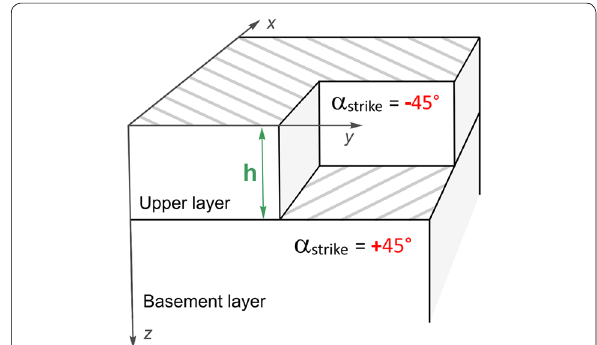
Fig. 1 Anisotropic 1-D model. Principal resistivities for both layers are ρ